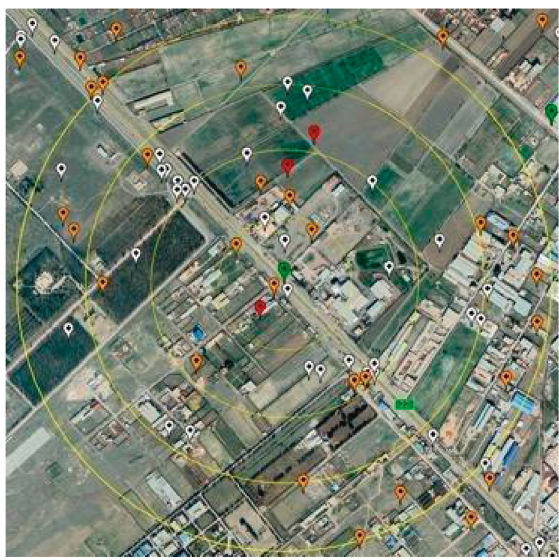
Figure 1: Integration of traffic attributes and crashes in ArcGIS. Table 3: Calibration result of ordered logit